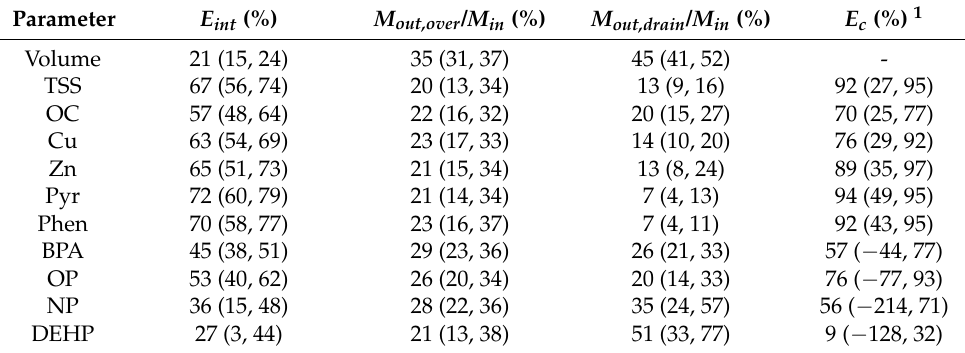
Table 4. Summary of water volume and pollutant mass reduction E int , proportions of inlet volume and loads accounted for in overflow ( M out,over / M in ) and in drained water ( M out,drain / M in ) and event mean concentration reductions ( E c 1 see [23] for more details), median and 95% confidence